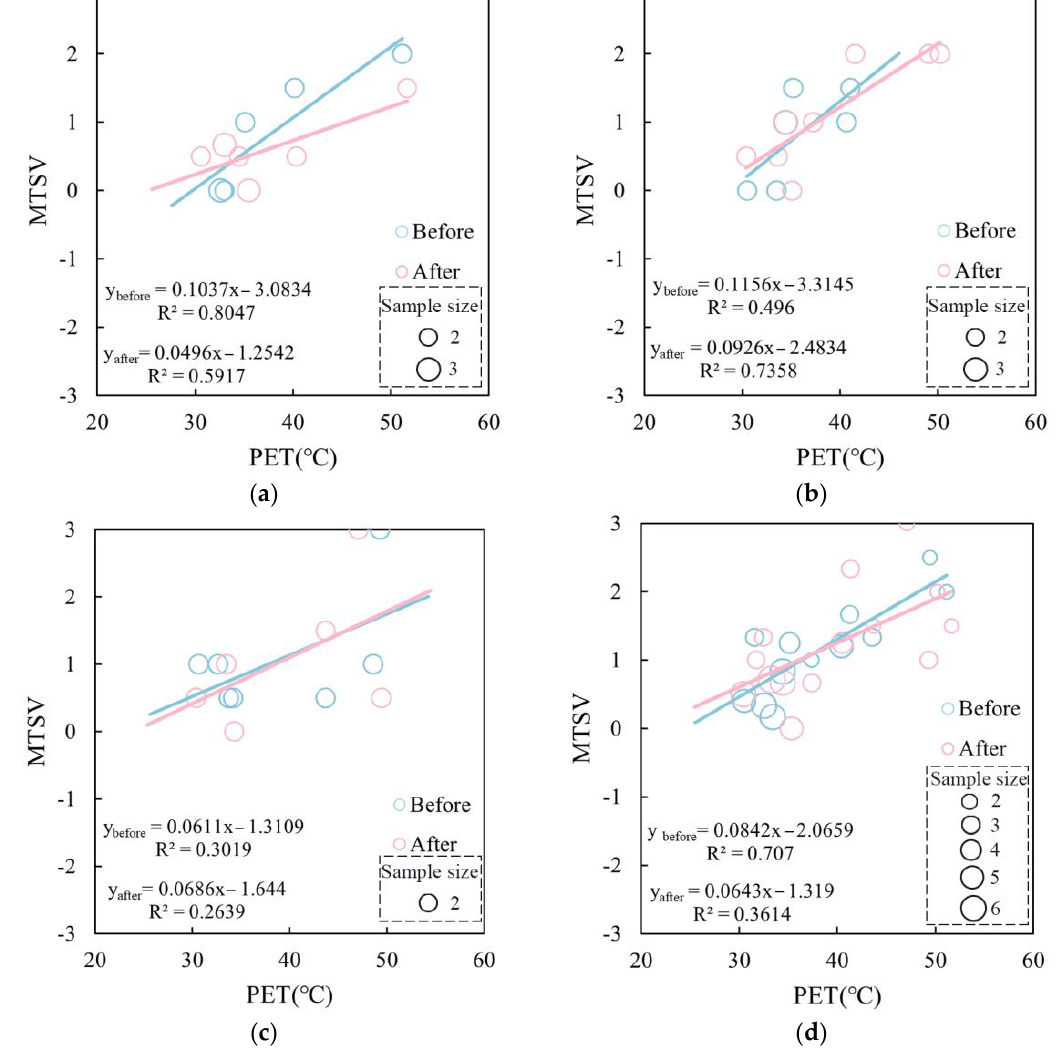
Figure 7. Correlations between PET and mean TSV at different horticultural activities (flower arrangement ( a ), transplanting and planting ( b ), laying crushed stone ( c ), and total ( d